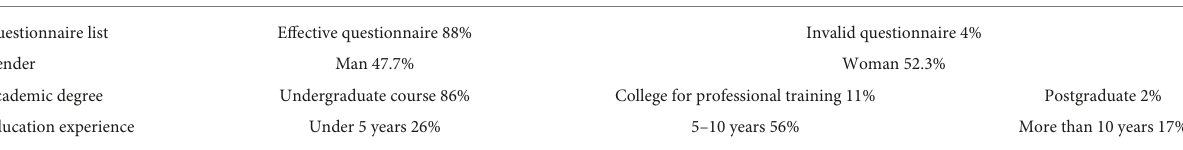
FIGURE9 Employment expectations.